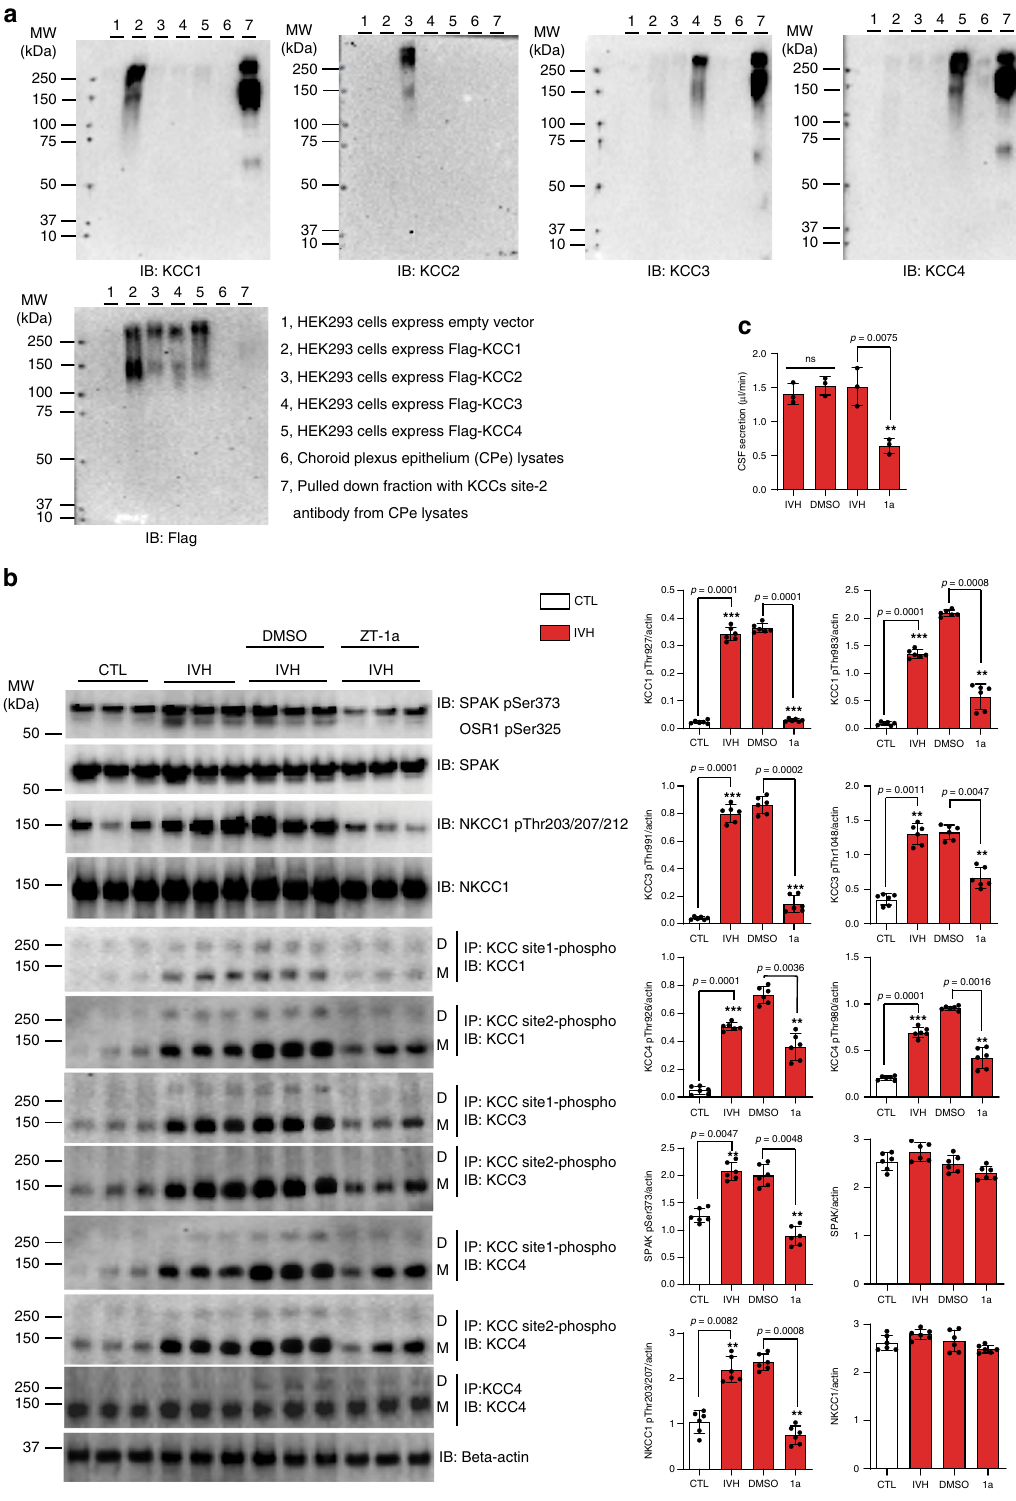
reduced stroke-induced lesion volume by ~40% and longer-term brain atrophy (% hemisphere shrinkage) by ~41% ( p < 0.05, n = 6, Fig. 7d). To assess the effect of ZT-1a on stroke-induced white matter injury, we analyzed fractional anisotropy (FA) and directionally encoded color (DEC) maps of the corpus callosum (CC) and external capsule (EC) in the vehicle-control and ZT-1a- treated brains. DEC and FA maps revealed intact CC and EC NATURE COMMUNICATIONS| (2020) 11:78